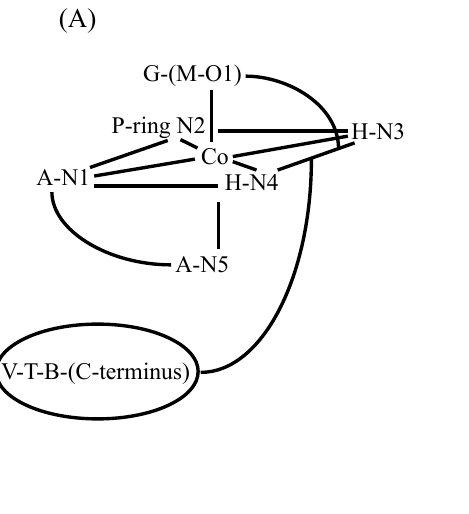
Figure 9. Coordination of Co(II) [48] to BLM-A The oxygen atom of the carbamoyl ( A ) or a solvent molecule ( B ) are bound as axial